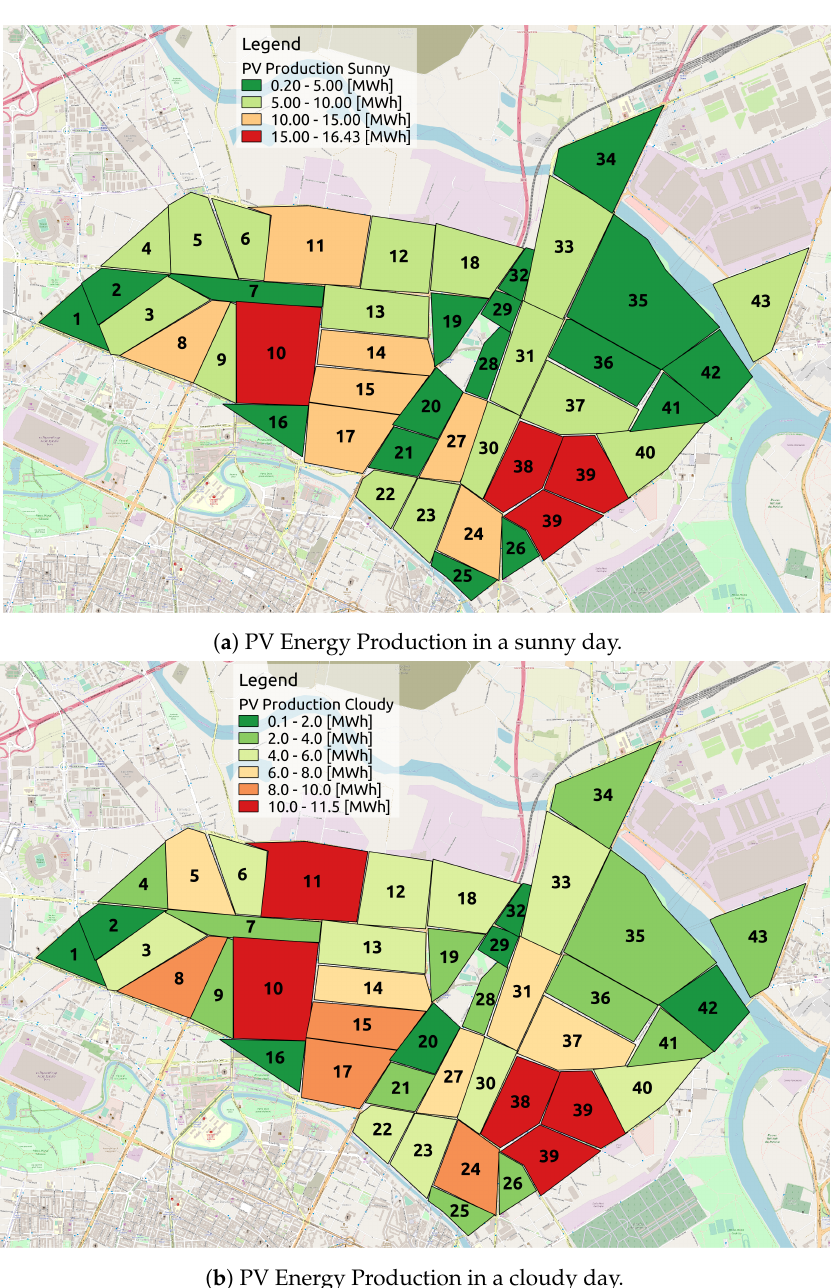
Figure 9. PV energy